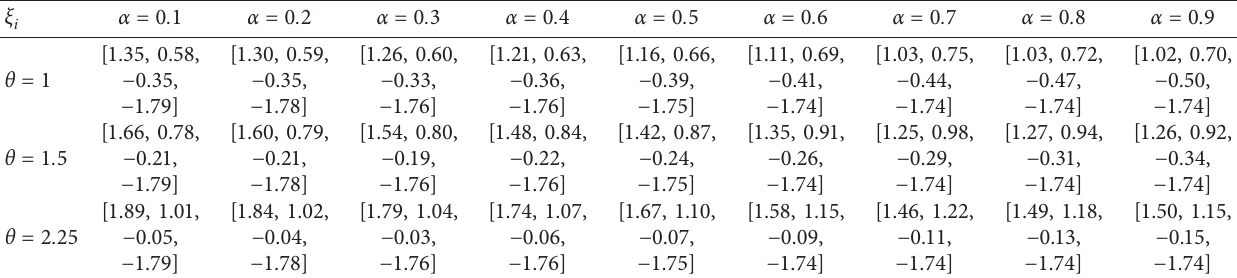
Table 5: Aggregating matrix R � ( 􏽥 r